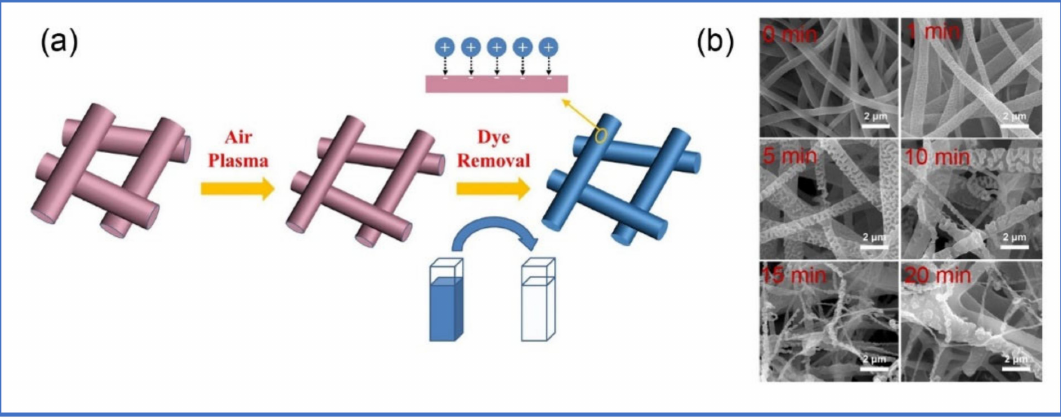
Figure 3. ( a ) plasma-treated polylactic acid (PLLA) electrospun membrane ( b ) effect of duration plasma treatment on morphology of PLLA nanofibers [79]. Copyright © (2020)